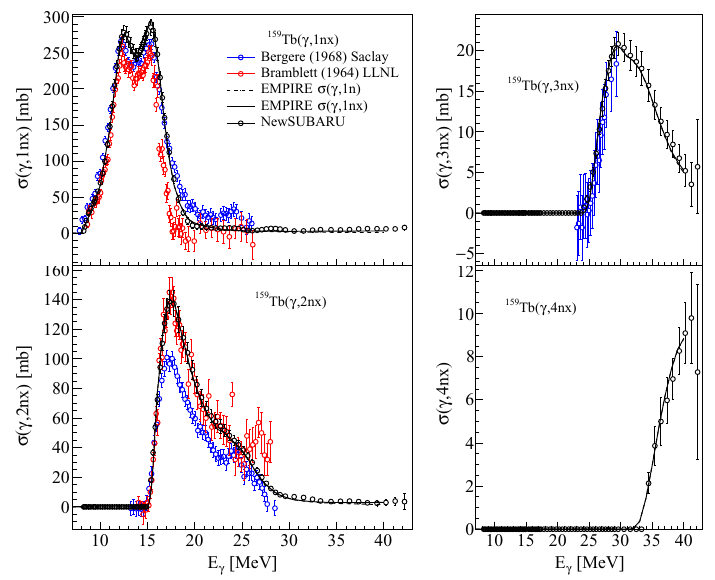
Figure 7. (Color online) The present partial photoneutron cross sections, σ ( γ, in ) with i = 1-4, for 159 Tb compared with the Livermore [22] and Saclay [23] data.